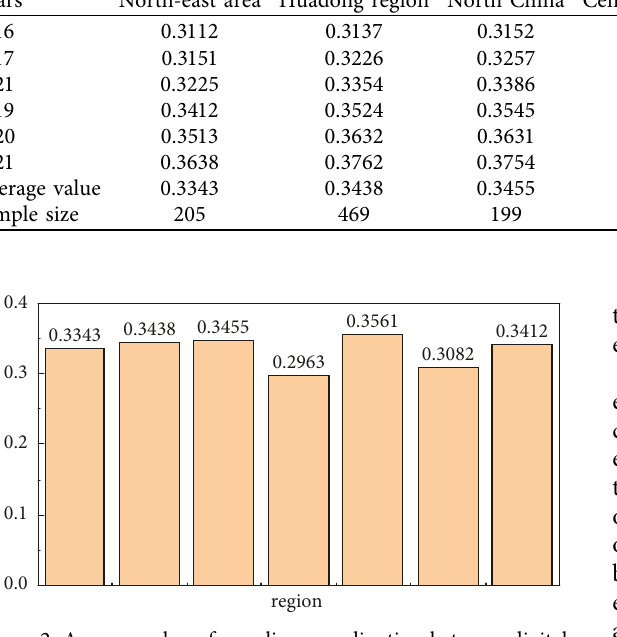
Figure 2: Average value of coupling coordination between digital economy and high-quality development in seven regions of